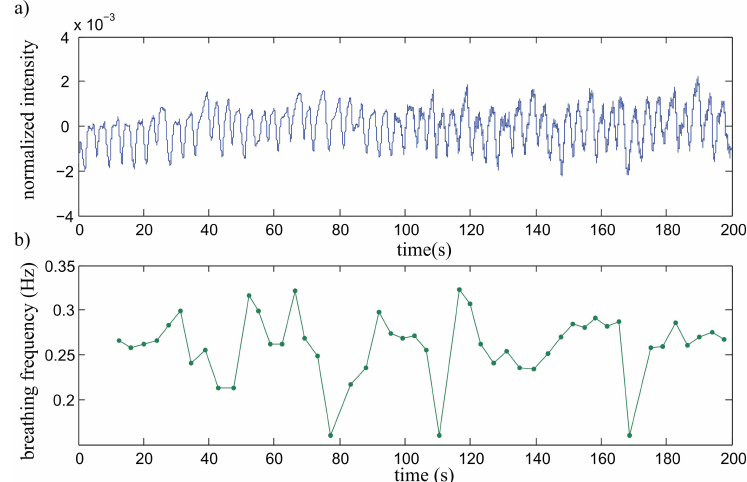
Figure 5. ( a ) Measurement data over 200 s showing regular breathing and ( b ) fast adaptive evaluation of the breathing frequency using an audio processing approach [18].